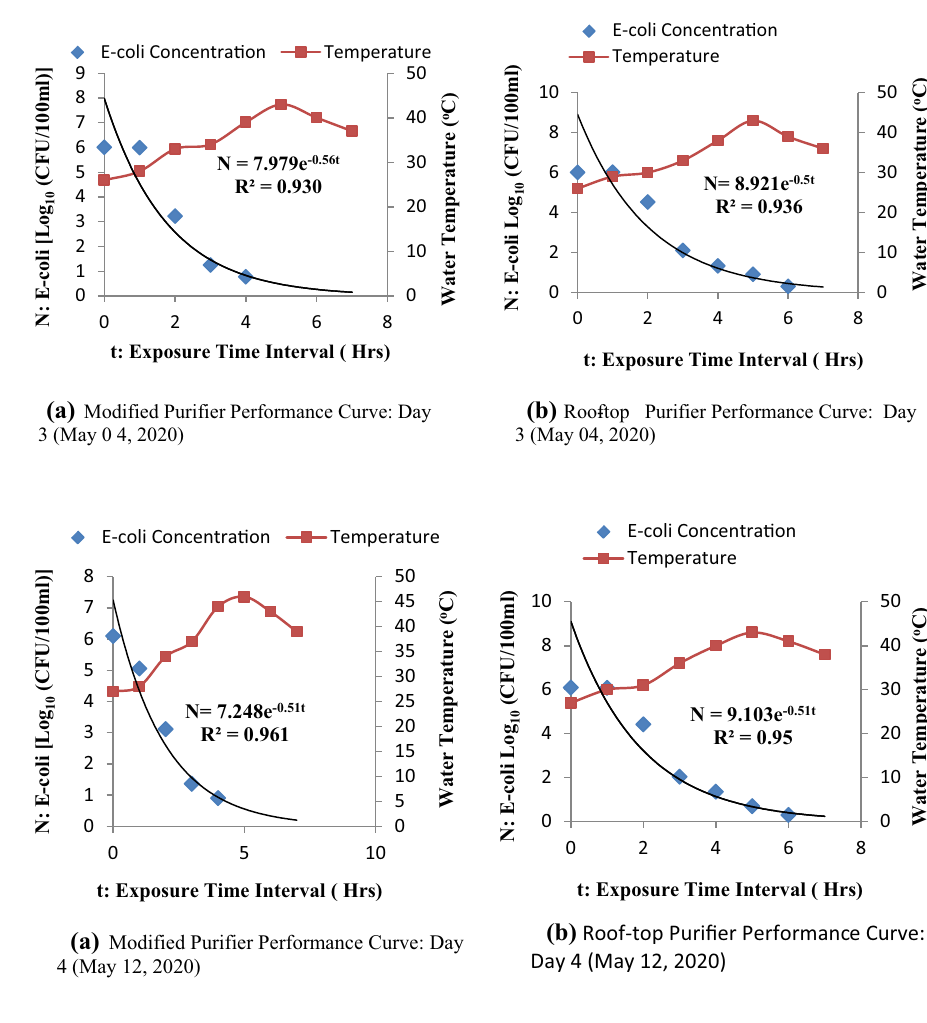
Fig. 12 a and b Day 5: Side- By-Side Performance Curves of the Improved SODIS and the Conventional SODIS